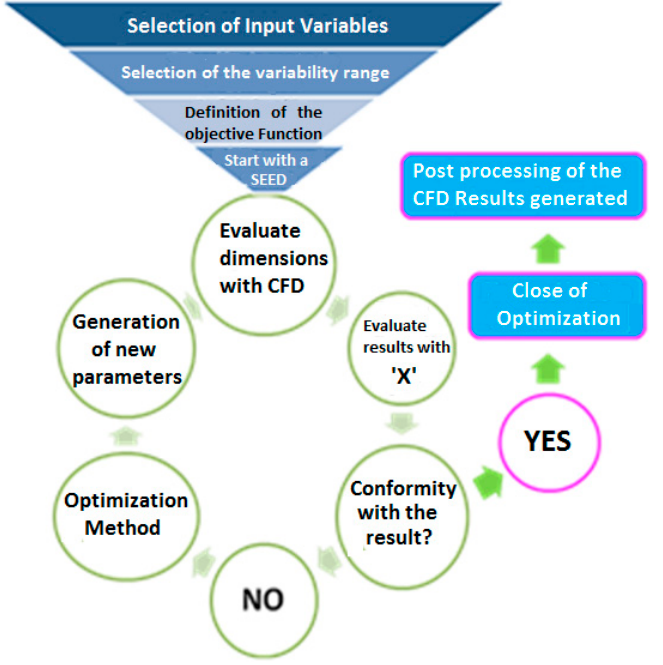
6 of 19 Figure 7. Simulation domain of jet pump. 3.2. Jet Pump Design and Optimization An optimization routine to iterate over the main dimensions, combining their perfor- mance analysis through the CFD, was implemented to design an optimal jet pump con- figuration. CFD commercial code ANSYS CFX ® (v-14, Canonsburg, US) and the optimiza- tion algorithms of the Pipeit ® (Version 1.0, Throdheim, Norway) tools have been used.